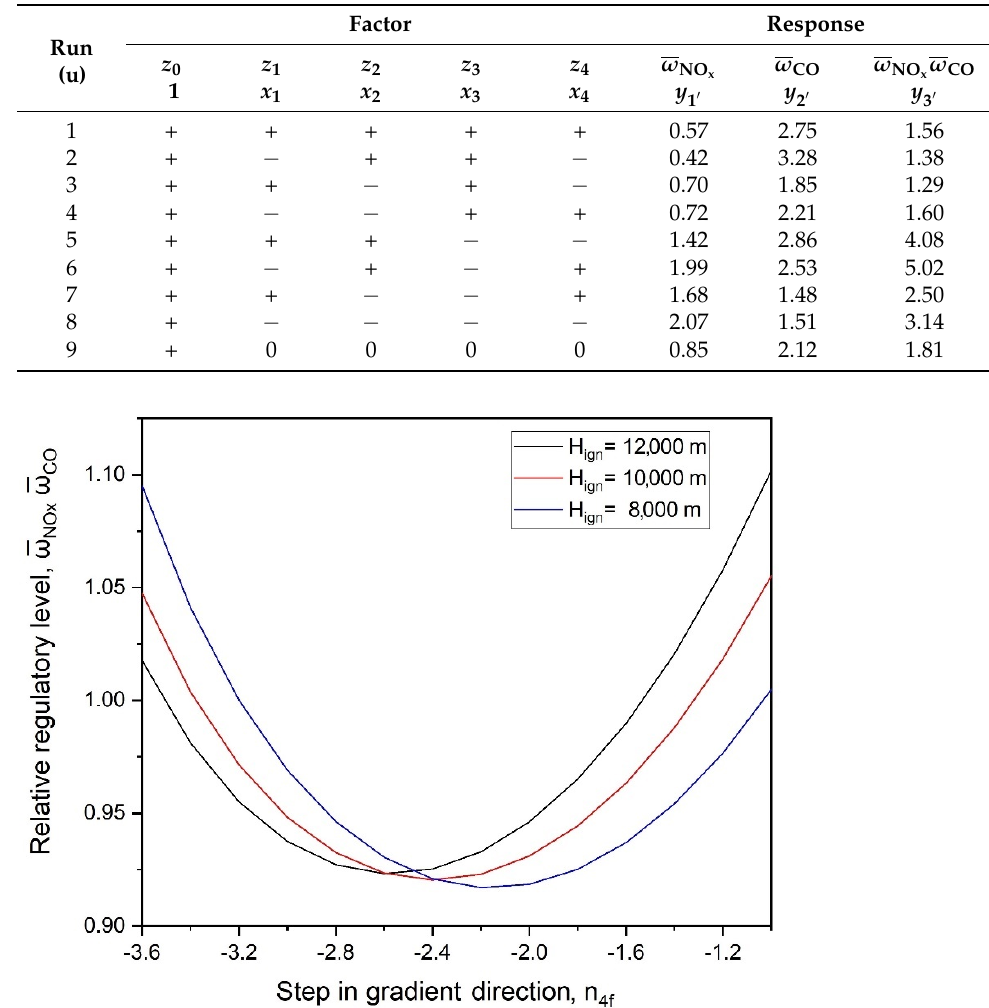
Table 6. Fractional factorial design and experimental results involving four factors.